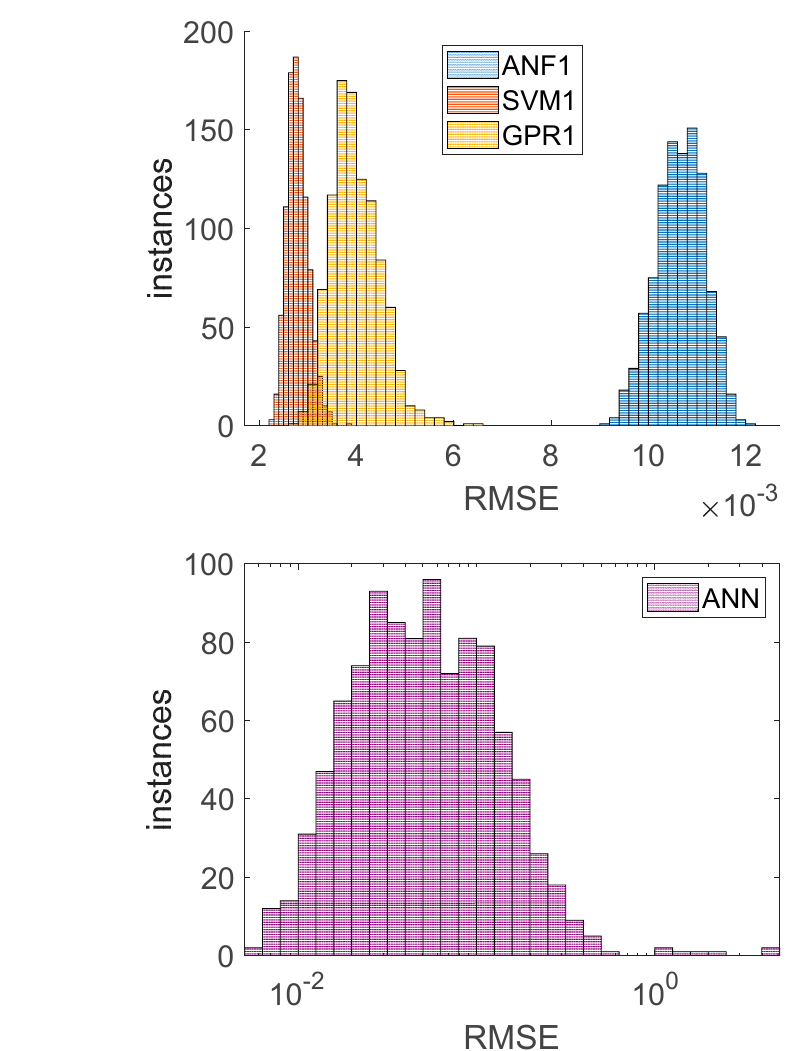
Figure 16. Histograms of RMSE for training 1000 models: ( a ) ANF1, SVM2, and GPR2 models, ( b ) ANN models. Sensors 2020 , 20 , x Table 8. Comparison of statistical RMSE data for training 1000 models.